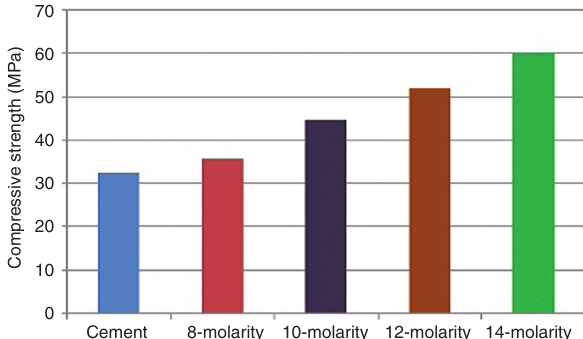
Figure 11 Compressive strength